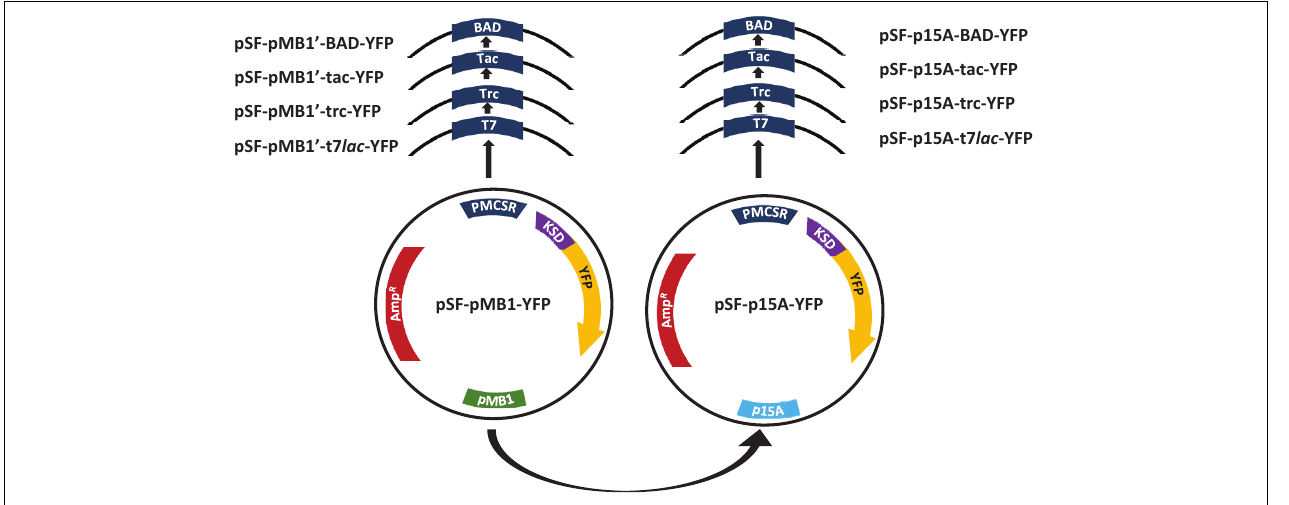
FIGURE 1 | Scheme of expression vectors constructed in this study. PMCSR, promoter multicloning site region; KSD, Kozak Shine-Dalgarno; YFP, yellow fluorescent protein; Amp R , ampicillin resistance.